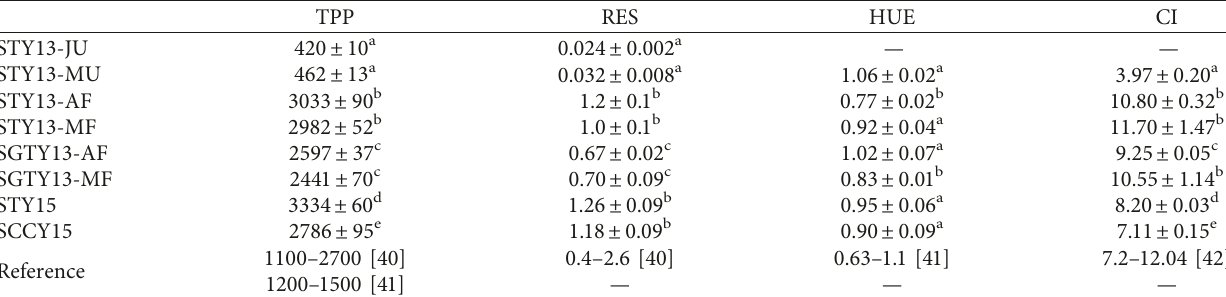
Table 3: Contents of selected antioxidant indicators in STY13 and SGTY13 wine samples at different wine-making stages and STY15 and SCCY15 refined wines. TPP